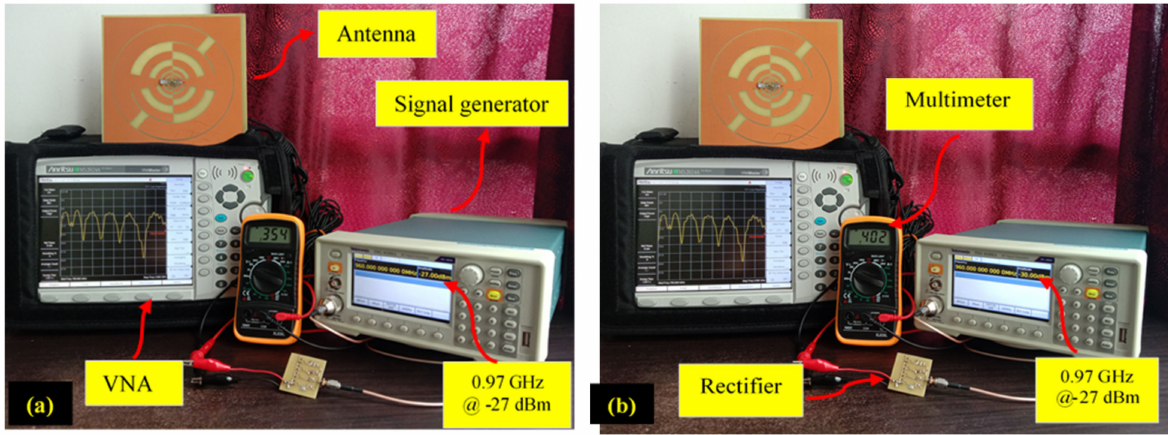
Figure 22. The measurement setup for antenna and rectifier in lab environment ( a ) for − 35 dBm RF input ( b ) for − 27dBm RF